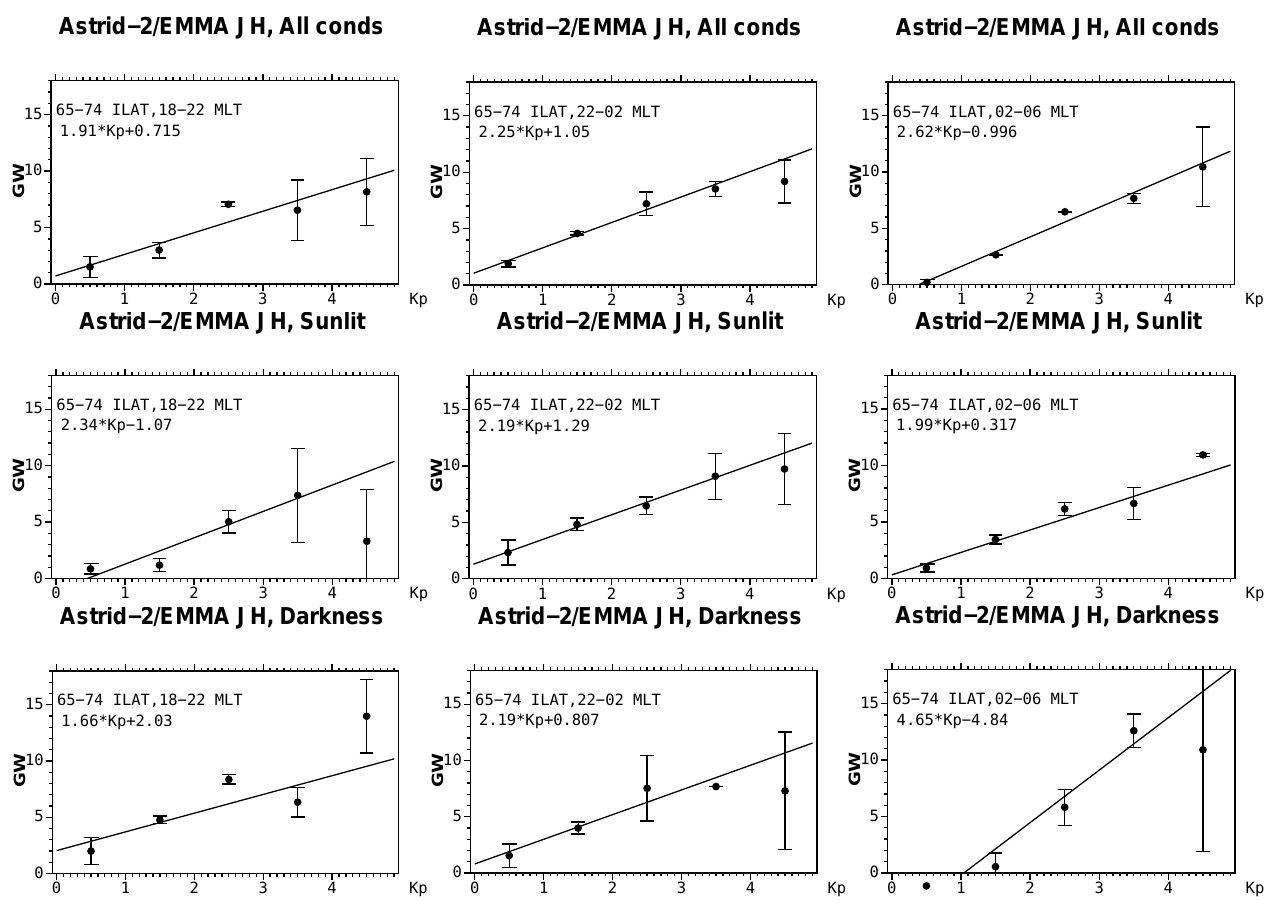
Fig. 8. Dependence of the average Joule heating on K p in the auroral zone (ILAT 65–74) for various MLT and solar illumination conditions. The three columns show the average Joule heating for three different nighttime MLT sectors and the upper row for all solar illumination conditions, the middle row for sunlit conditions and the bottom row for darkness conditions. The solid lines shows a fit to the data and the corresponding formula is shown in each subplot, as well as in Table 1, row 7–9. The Joule heating is roughly the same for sunlit and darkness conditions apart from MLT 18–22, where they are much higher for darkness